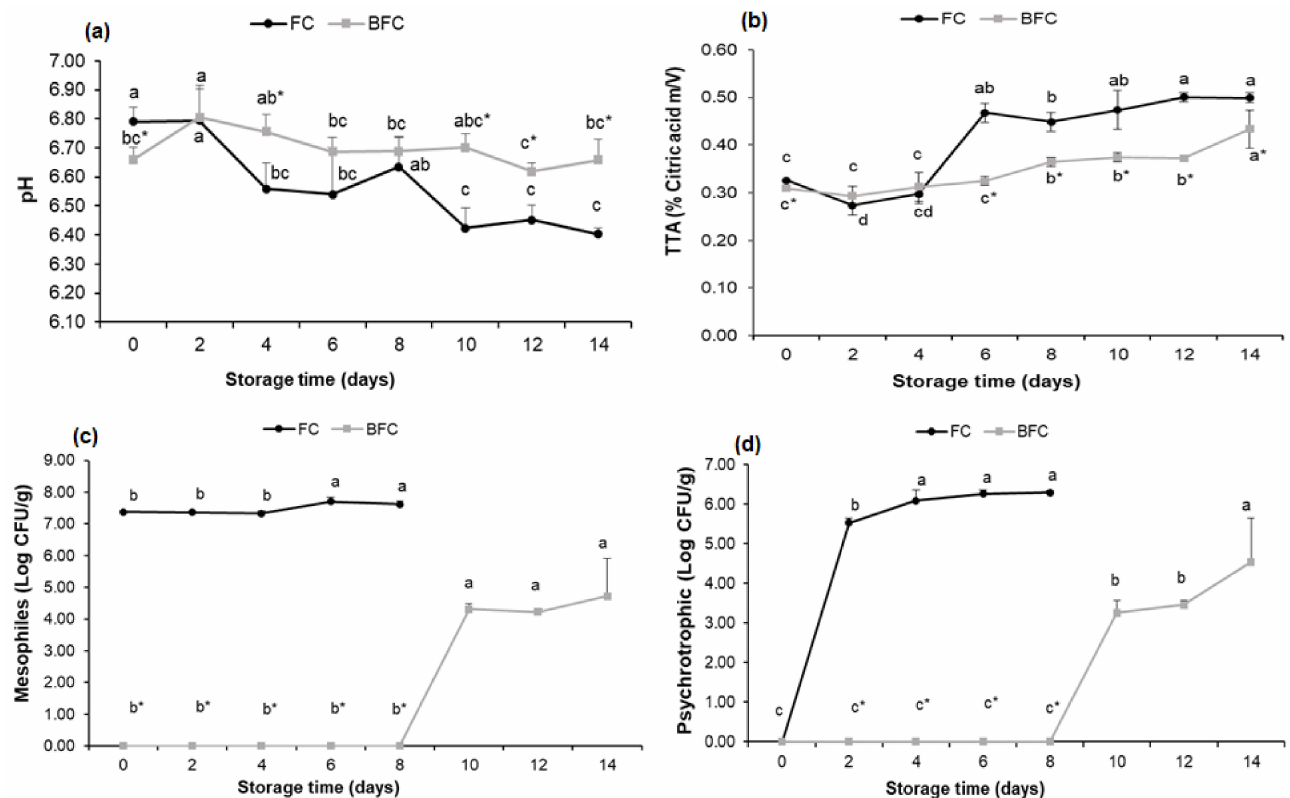
Figure 4. Effect of refrigerated storage (4.90 ◦ C) on: ( a ) hydrogen potential (pH), ( b ) total titratable acidity (TTA), ( c ) on the mesophiles (Log CFU/g) and ( d ) psychrotrophic bacteria (Log CFU/g) counts of fresh cowpea (FC) and blanched fresh cowpea (BFC) samples at 70 ◦ C for 4 min. Mean of two samples and standard deviation bar. Each sample was analyzed in triplicate. abcd Means with different letters in the same line differ significantly ( p < 0.05) according to the Tukey test. * Means followed by an asterisk differ significantly ( p < 0.05) from the control (FC) according to the Student’s t